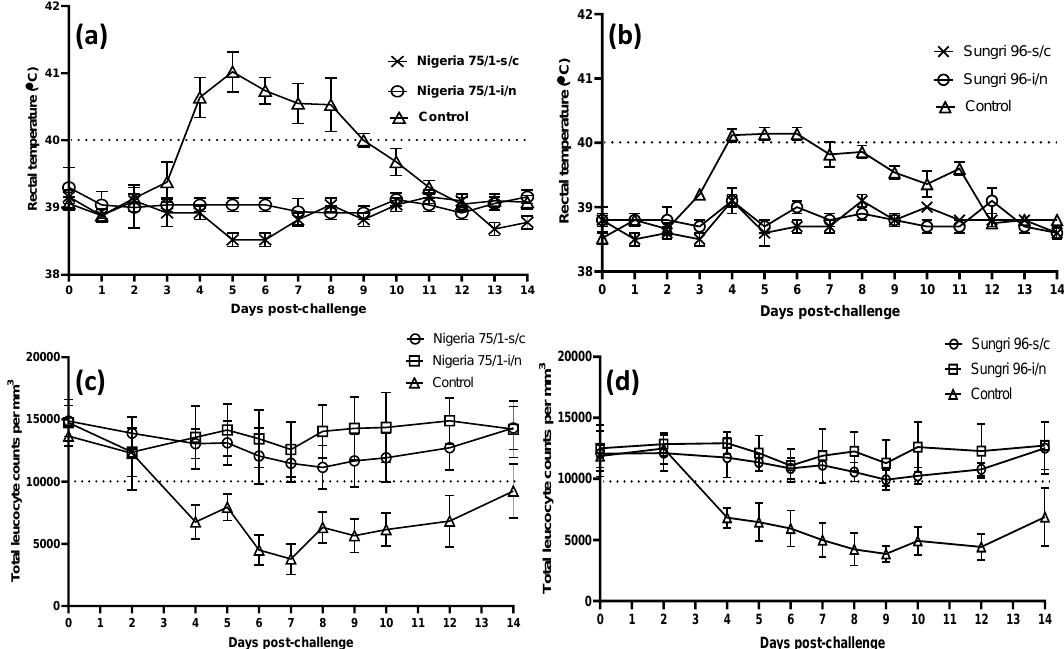
Figure 1. Average rectal temperature and leucocyte count in goats following challenge with virulent peste des petits ruminants virus (PPRV). Average rectal temperature and leucocyte count of five animals in each group are shown in the graph. ( a ) Average rectal temperature in Nigeria 75 / 1 vaccine study; ( b ) average rectal temperature in Sungri 96 vaccine study; ( c ): average leucocyte count in Nigeria 75 / 1 vaccine study; ( d ) average leucocyte count in Sungri 96 vaccine study. The dotted line in each graph shows the normal body temperature / leucocyte count.